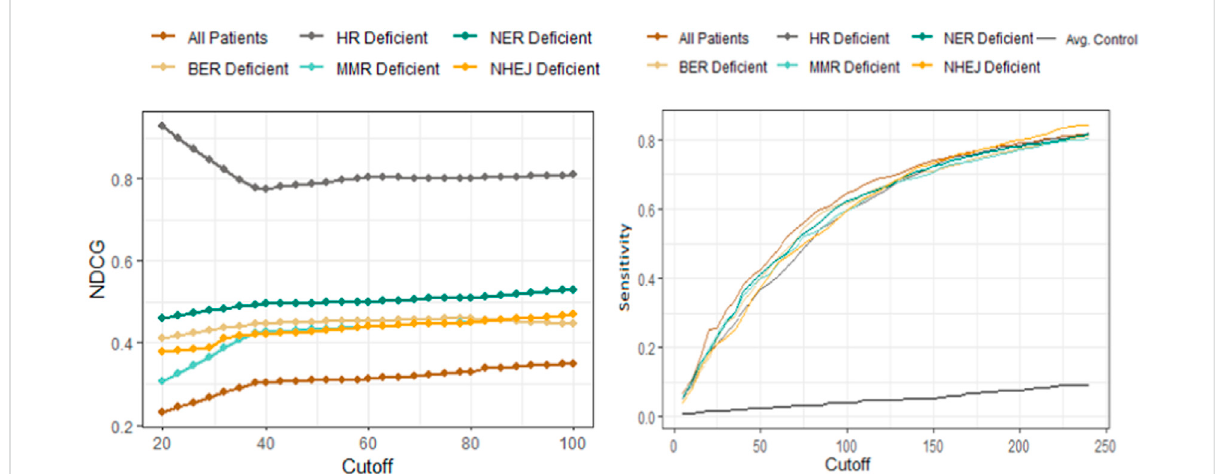
FIGURE 4 Performancecomparisonofthedrug-diseasesimilaritymodelonDNA-repairde fi cientpatientsubpopulationsusingNDCG(left)andsensitivity analysis (right).TheNDCG/sensitivityvalues(verticalaxes)ofalldrug – indicationassociationsusingdifferentDNArepairde fi cientsubpopulationsare shown according to different cutoff values (horizontal axis). The NDCG results clearly demonstrate that the HR-de fi cient subpopulations result in drugs that are clinically more relevant with more FDA-approved/investigational drugs compared with other DNA-repair pathway de fi ciencies. The plot has further shown that identifying homogeneous subpopulations through common biomarkers result in better performances when compared to all patients combined. The sensitivity values demonstrate that the list of breast/prostate cancer drugs retrieved for all cutoff levels are clinically relevant and indicates an overall better performance relative to random controls (shown as the black